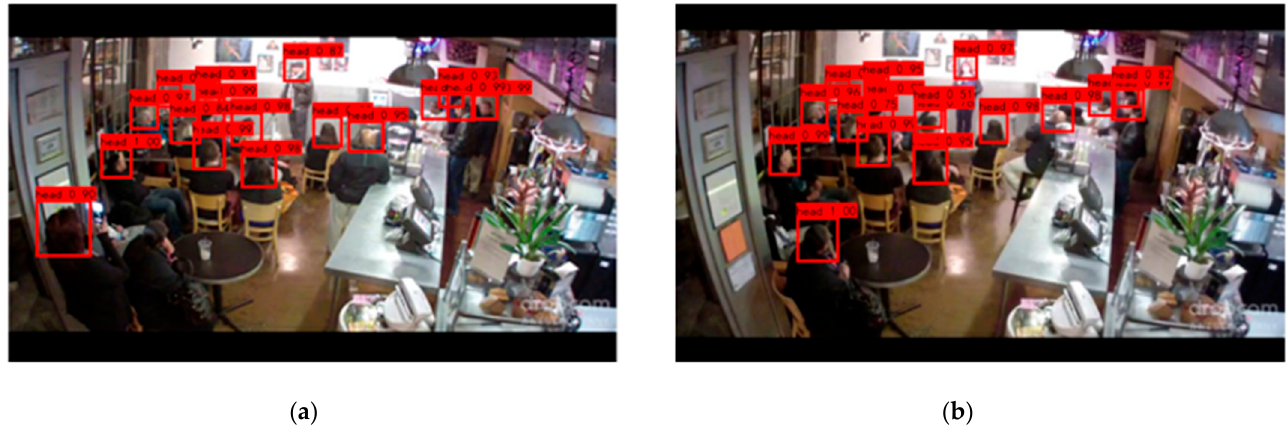
Figure 9. Test results without DPAC: ( a ) Detection results with DPAC with 18 people; ( b ) detection result without DPAC with 16 people.